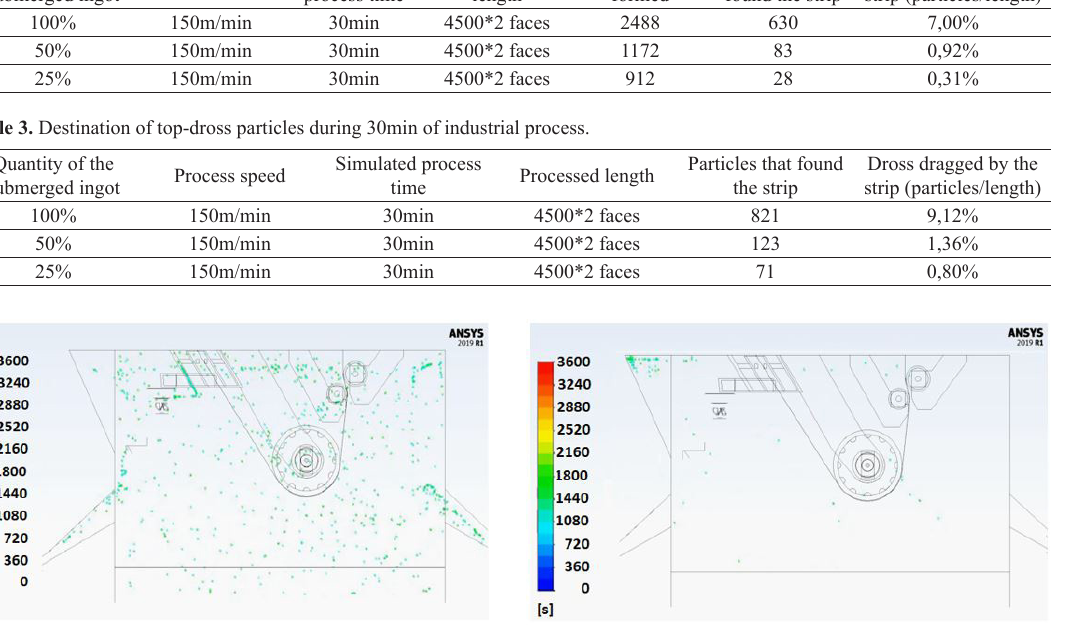
Figure 16. Top-dross particles generated from the fusion of the zinc ingot, completely immersed, still resident and dispersed in the galvanizing bath after 30 min (1800 s) of industrial process simulation.